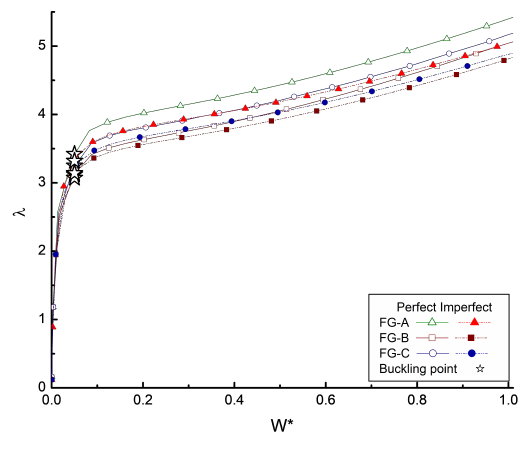
Fig. 8: A comparative load-deflection behavior of FG-CNT/ESF- reinforced Mg nanocomposite